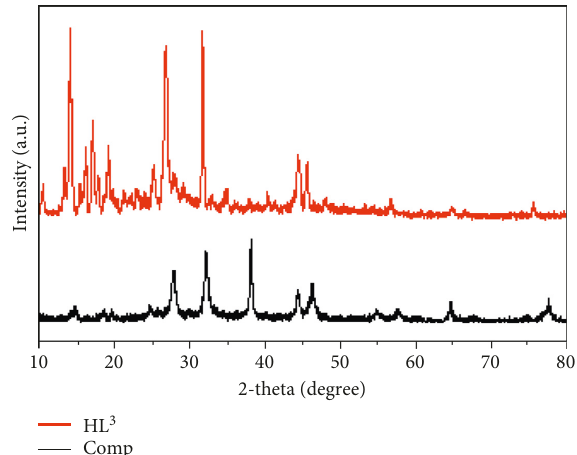
Figure 3: X-ray diffraction pattern of pyrazolone, HL 3 , and its AgNPs